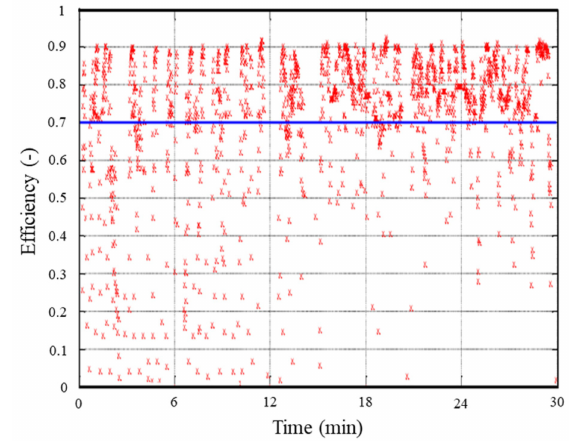
Figure 10. Distribution of motor